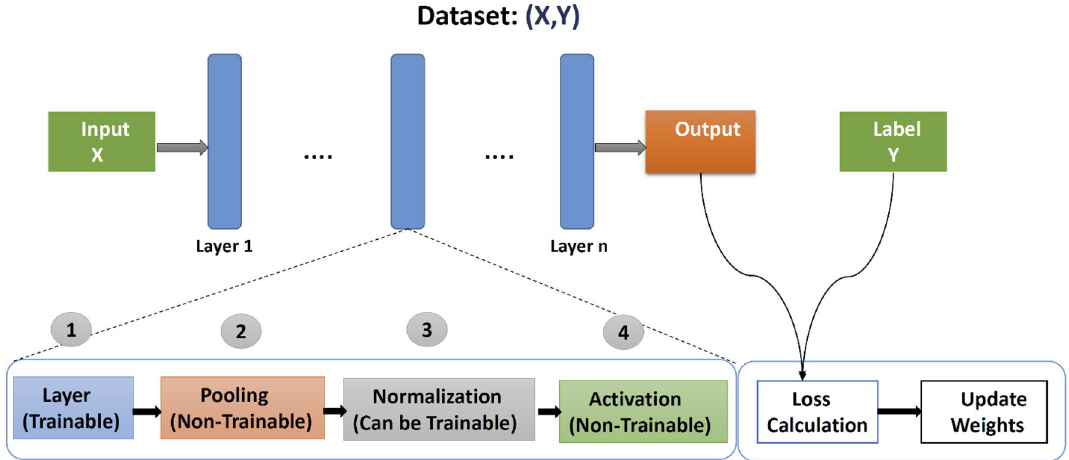
Figure 4. The template for a basic CNN (a simple CNN template with several building